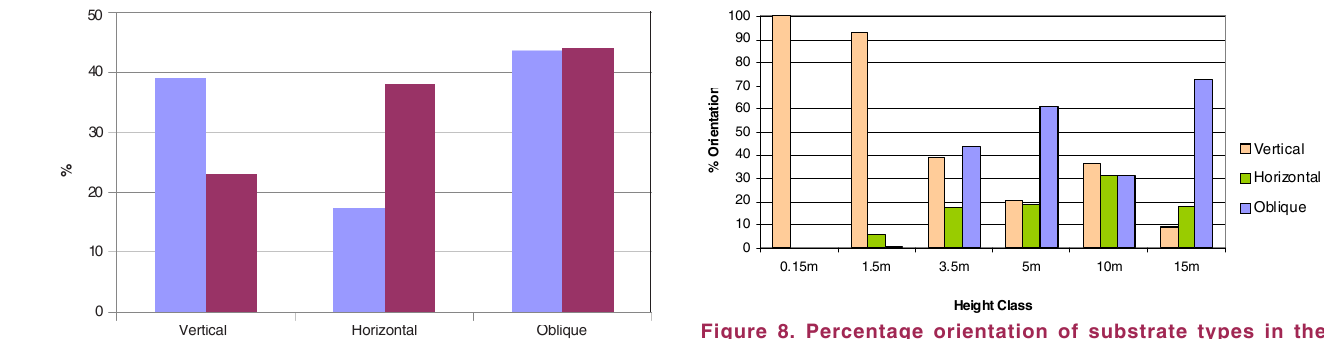
Figure 8. Percentage orientation of substrate types in the different heights of the vertical axis at Kottawa